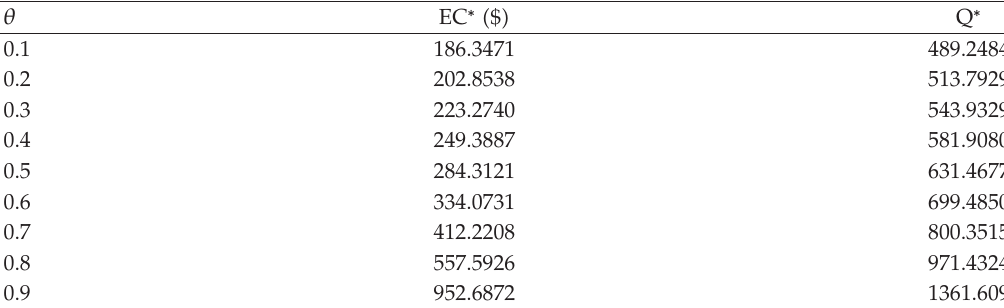
Table 1: Variation of “EC” and “ s ” with “ θ